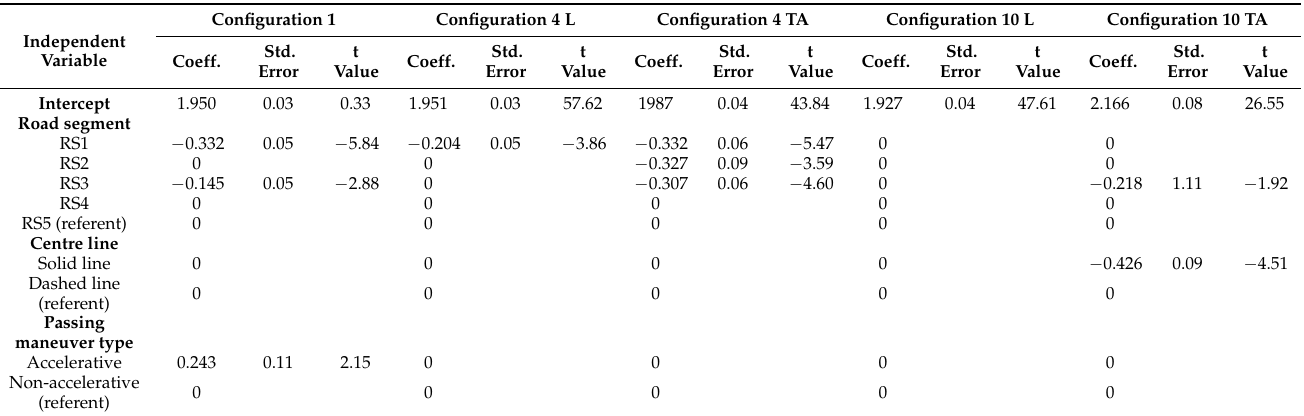
Table 4. Correlates of lateral clearance in multivariable linear regression